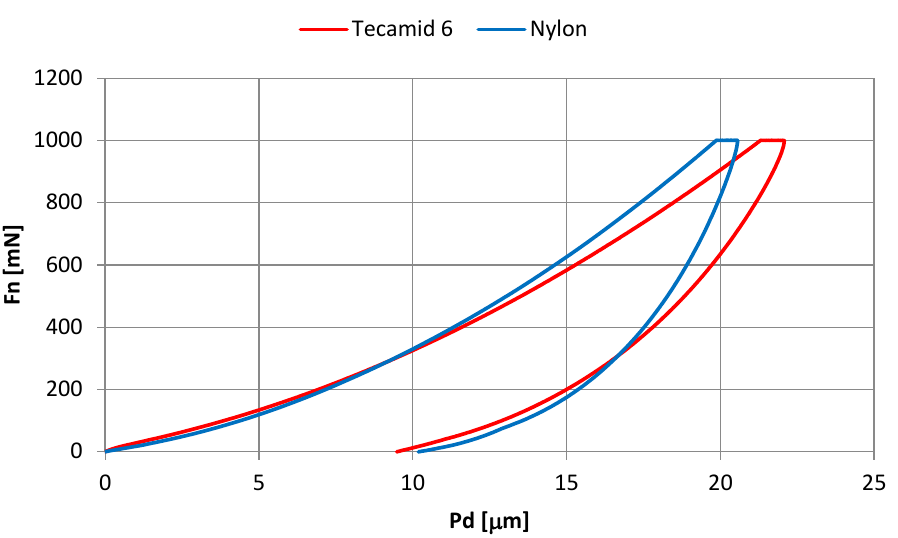
Figure 7. Mean normal curves (Fn) — penetration depth of the indenter (Pd).